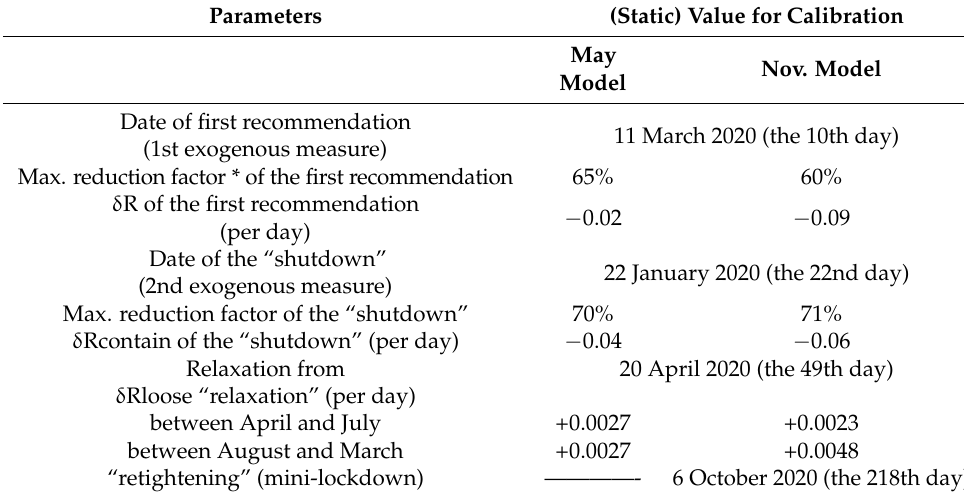
Table A2. Adapted parameters of the models.